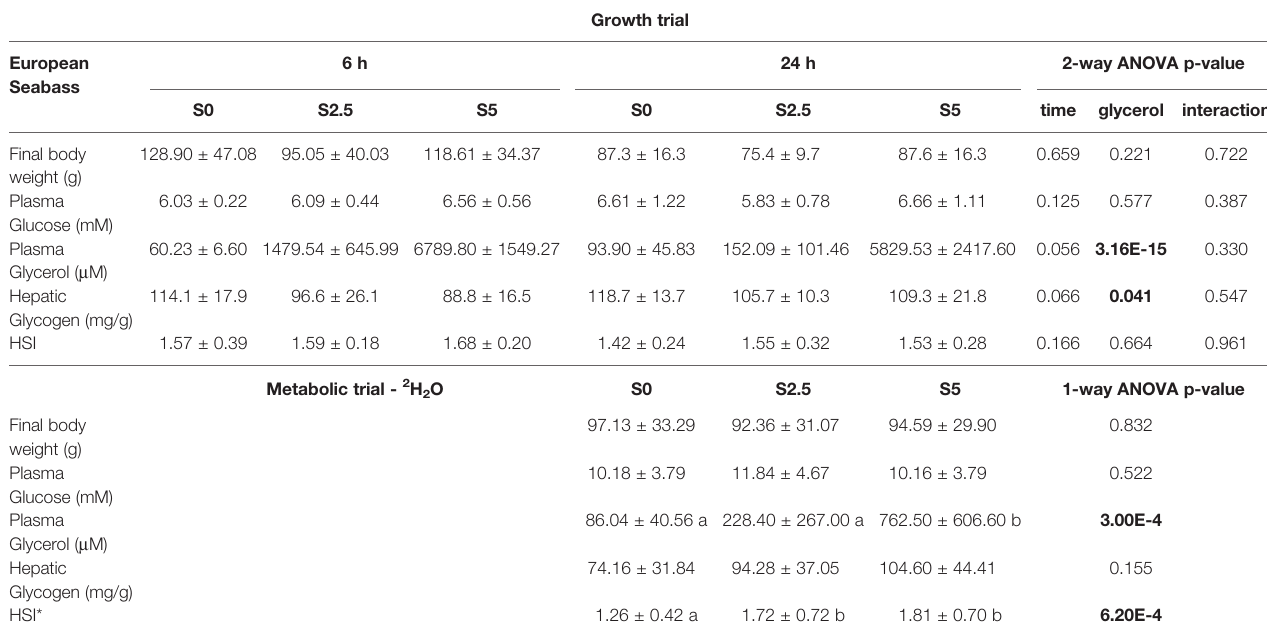
TABLE 4 | Final weight, blood and liver parameters for European seabass ( Dicentrarchus labrax ) fed with different levels of glycerol (0, 2.5, and 5%) for 6 weeks sampled at the end of the growth trial at 6 h and 24 h after last meal and the metabolic trial (6-day residence in 2 H-enriched water) 24 h after last meal. Growth